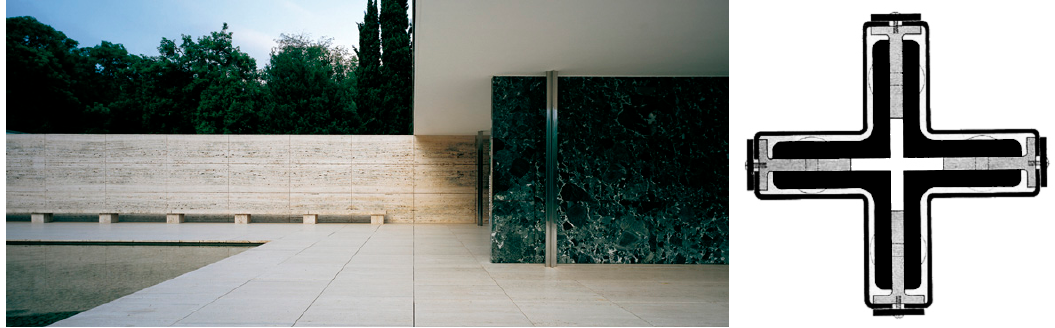
Figure 4. German Pavilion by Mies Van der Rohe, Barcelona International Exhibition, 1929 [9].